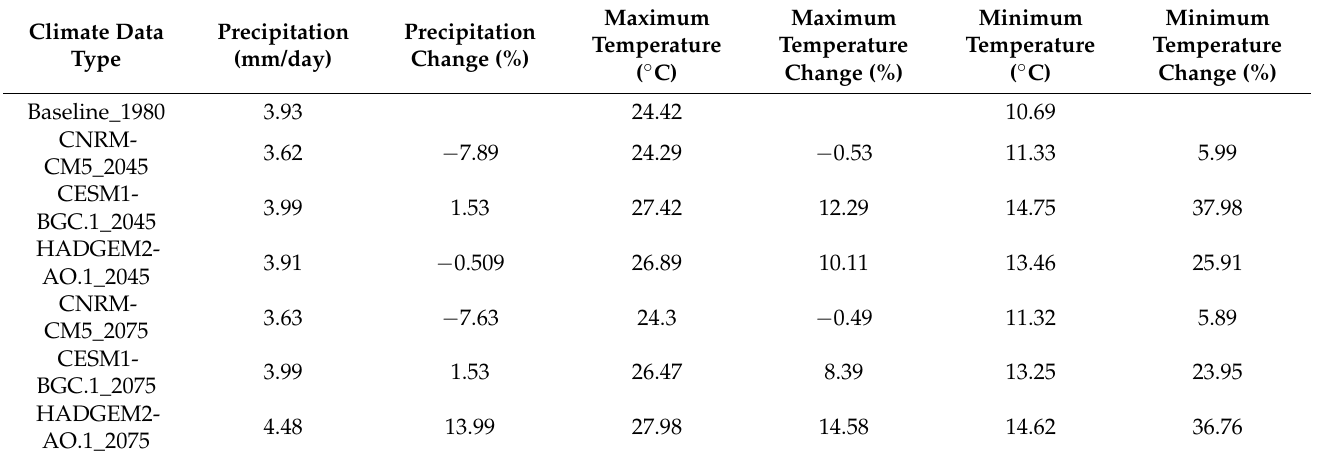
Table 3. GCM projected average daily climatic variables and percentage change to 1980 baseline